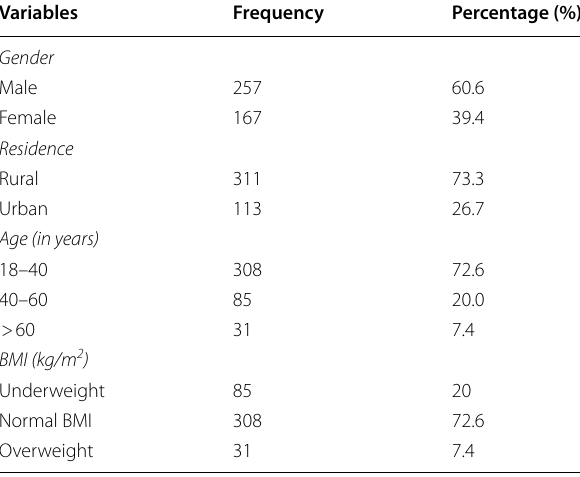
Table 1 Socio-demographic characteristics of